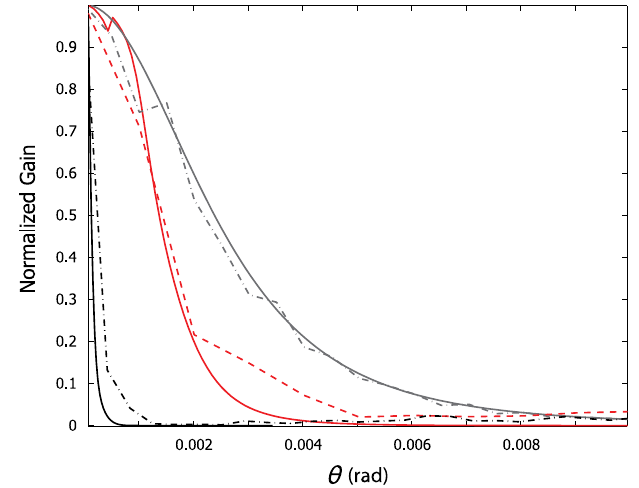
corresponding to (cid:7)